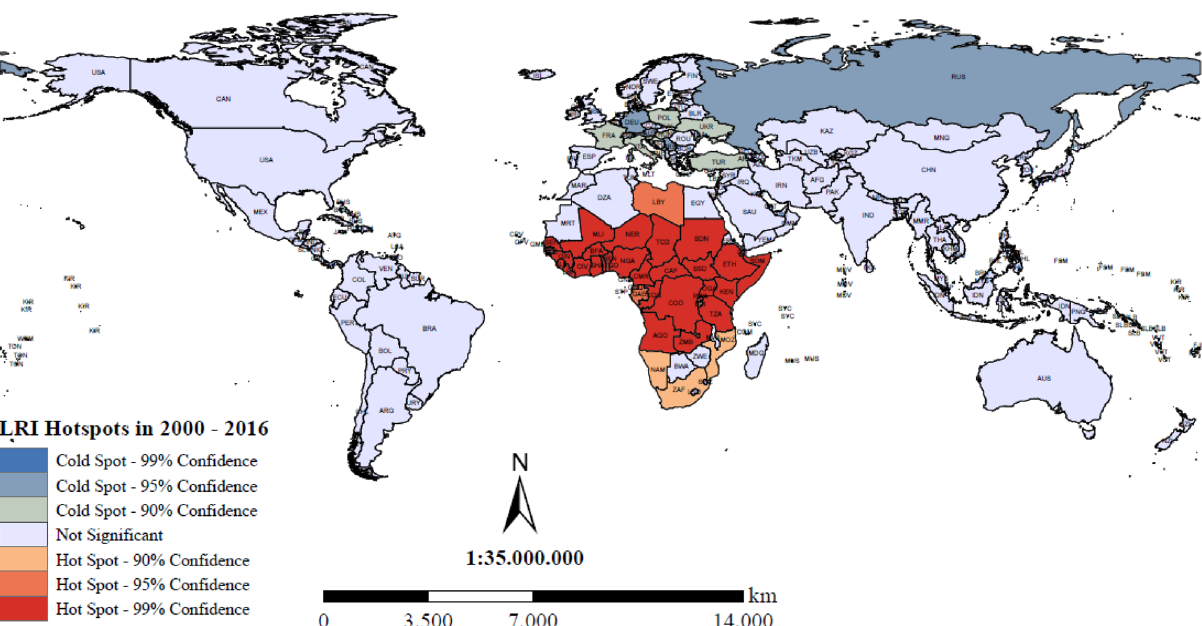
Figure 1. Spatial hot spots and cold spots of DALYs due to